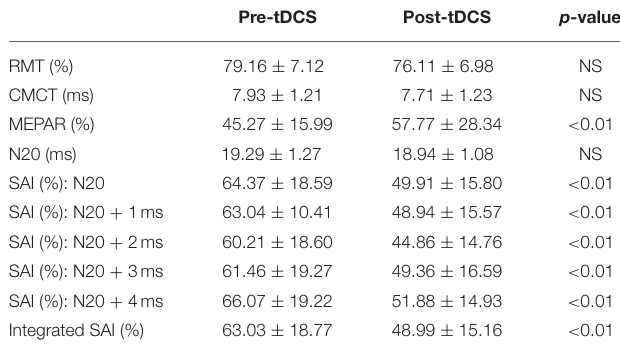
These values represent the mean with the SD. tDCS: transcranial direct current stimulation, PD, Parkinson’s disease; RMT, resting motor threshold; CMCT, central motor